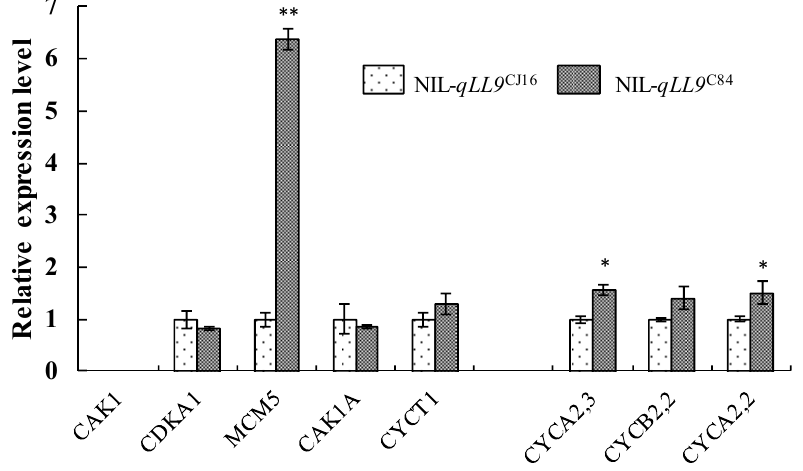
Figure 11. Comparison of eight cell cycle related gene expression between NIL- qLL9 CJ16 and NIL- qLL9 C84 at the heading stage by qRT-PCR, and the data are represented as mean ± SD ( n = 3); asterisks represent significant difference determined by Student’s t-test at p-value <0.01(**), p-value <0.05 (*).